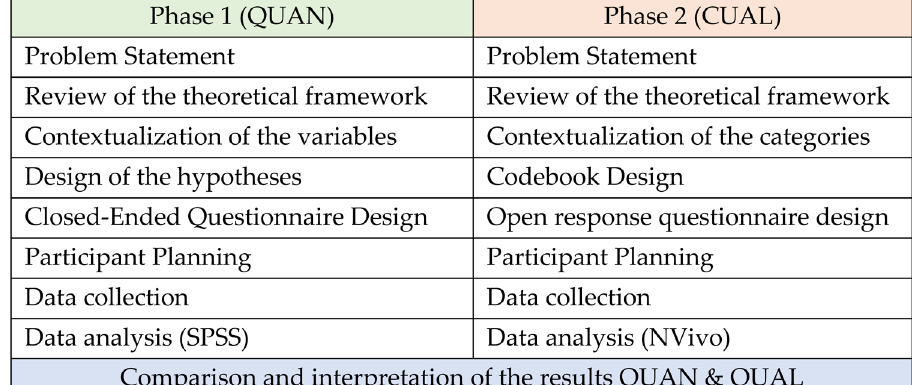
Figure 1. Outline of investigation